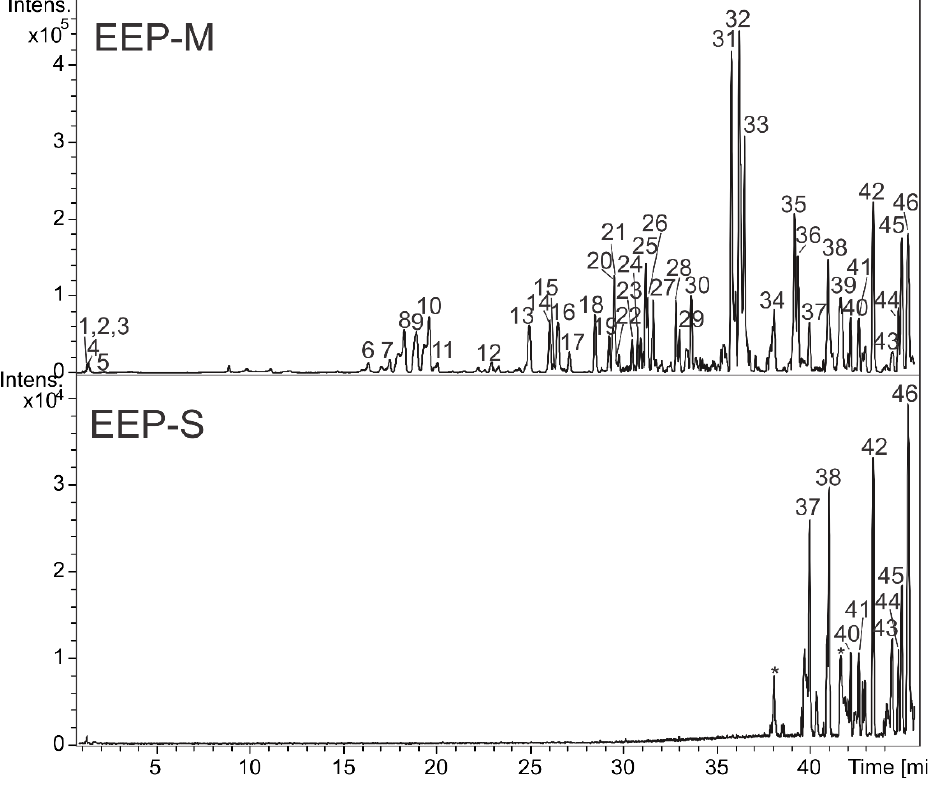
Figure 1. Base peak chromatogram (negative ion mode) from ethanolic extracts of Melipona quadrifasciata anthidiodes (EEP-M) and Scaptotrigona depilis (EEP-S) propolis by LC-DAD-MS. (* contaminant peaks from the chromatographic system.)